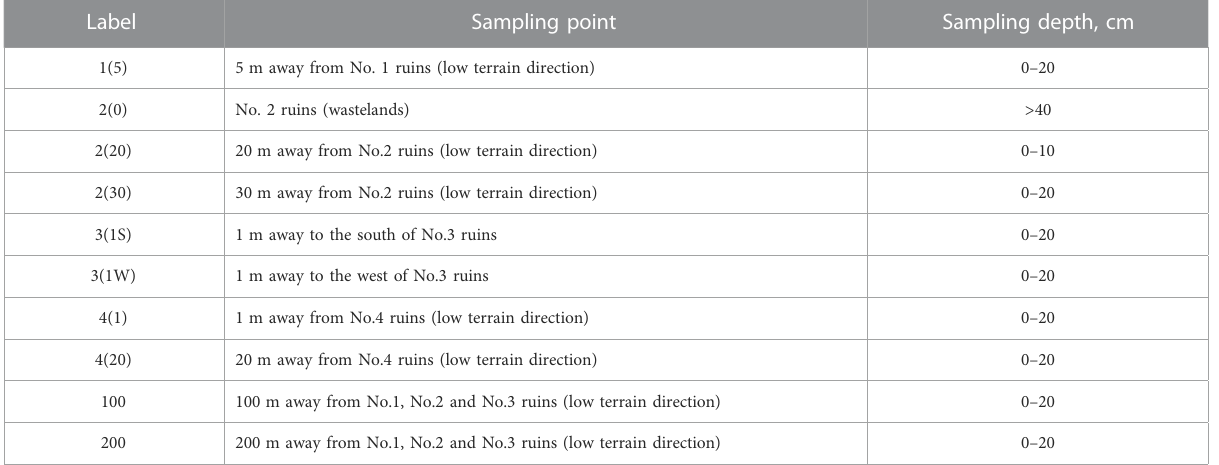
TABLE 1 Soil samples number detail information.